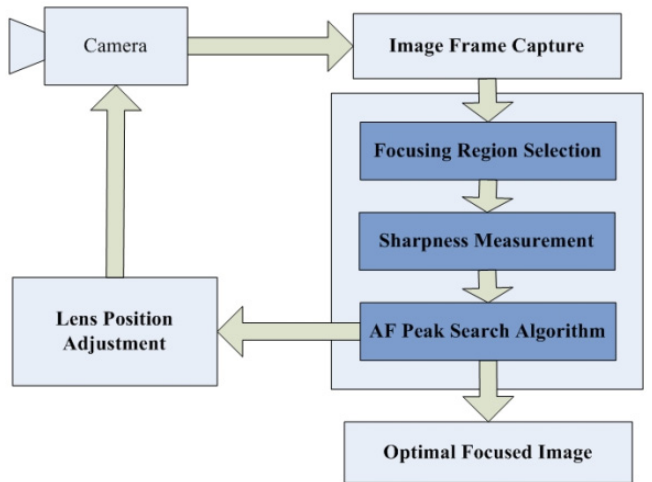
Figure 1. Traditional passive AF